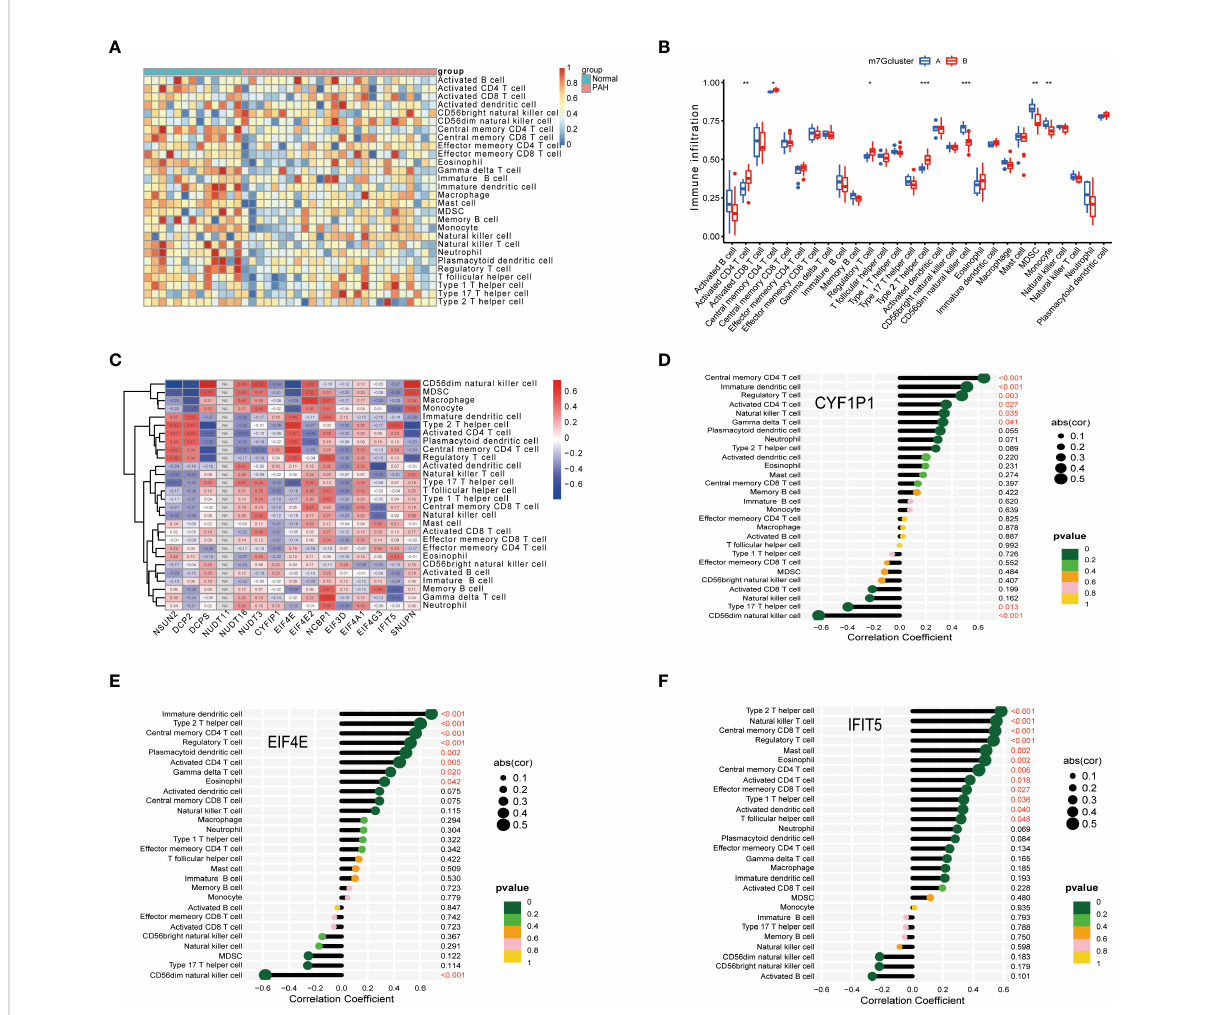
FIGURE 5 Correlation of disease characteristic genes and immune cells in PAH. (A) Differential analysis of immune cells. (B) Difference analysis of immune cells in m 7 G cluster. (C) Correlation analysis of immune cells and m 7 G regulators. (D) Correlation analysis of CYFIP1 gene and immune cells. (E) Correlation analysis between EIF4E gene and immune cells. (F) Correlation analysis between IFIT5 gene and immune cells. Spearman correlation analysis was used between genes and gene expression. The abscissa in the fi gure represents the correlation coef fi cient, the ordinate represents the immune cell, and the rightmost value represents the correlation p value, the correlation coef fi cient. *P < 0.05, **P < 0.01, and ***P <